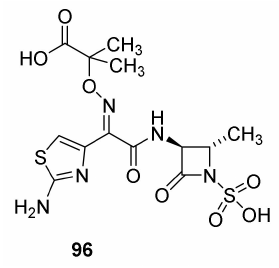
Figure 21. Aztreonam ( 96